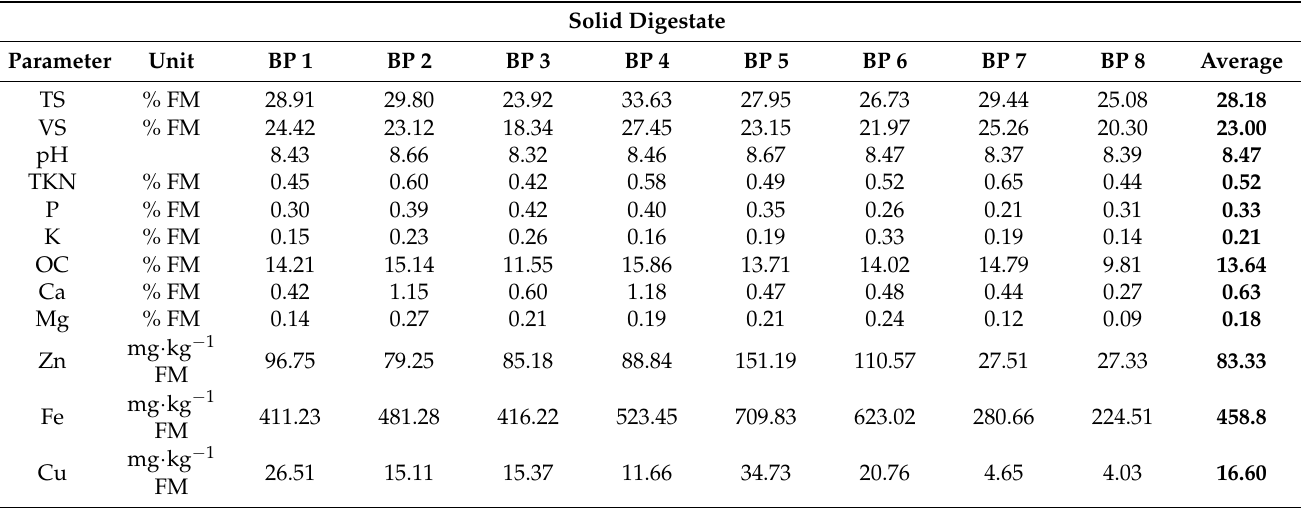
Table 5. Selected solid digestate parameters for 8 biogas plants. Solid